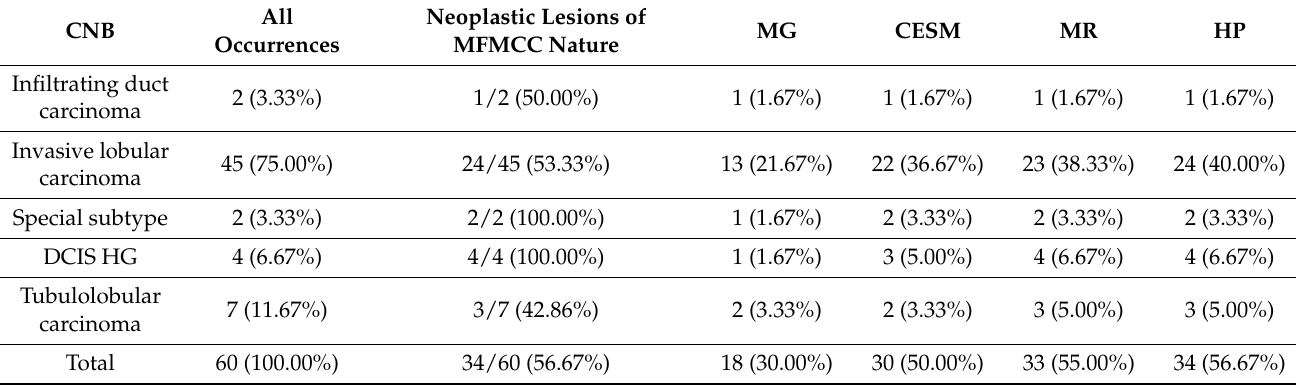
Table 2. The histopathological types of cancer detected as MFMCC (percentage values of the total